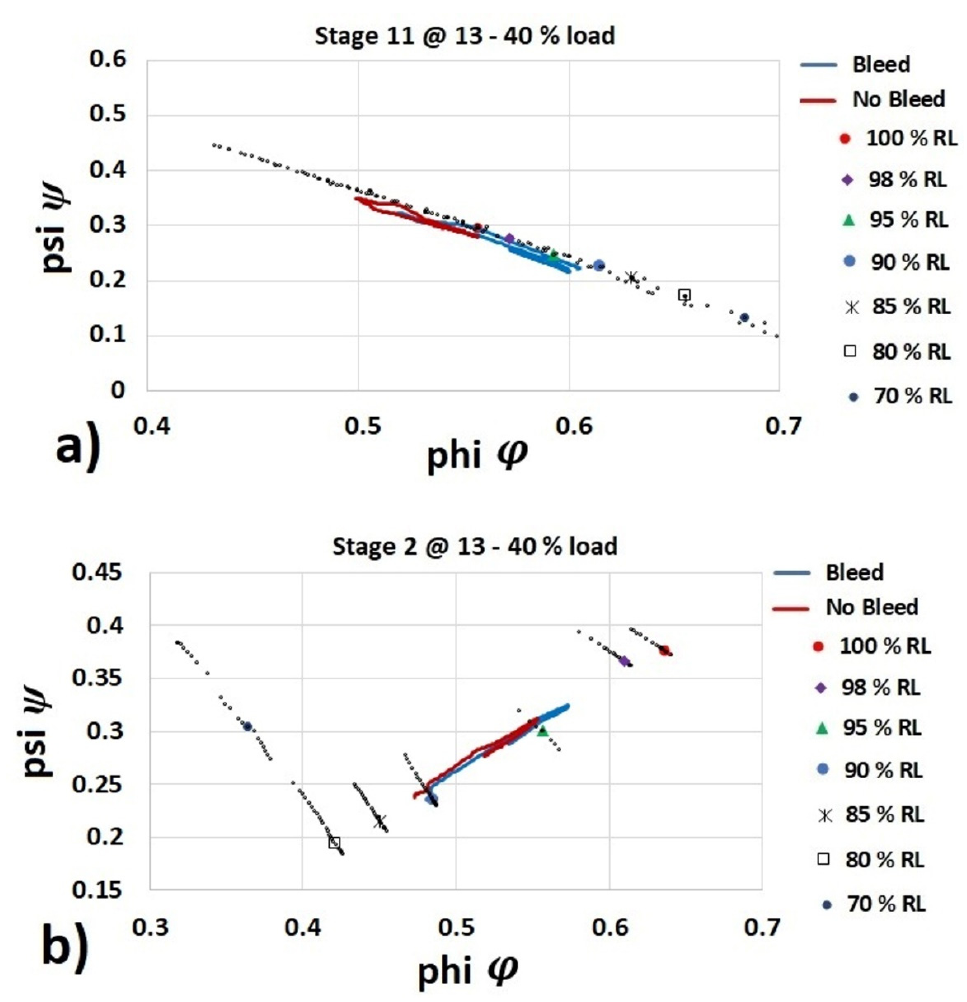
Figure 19. Compressor transient response on the stage characteristic map @ 13–40% load and with / without bleed air, ( a ) stage 11, ( b ) stage 2.